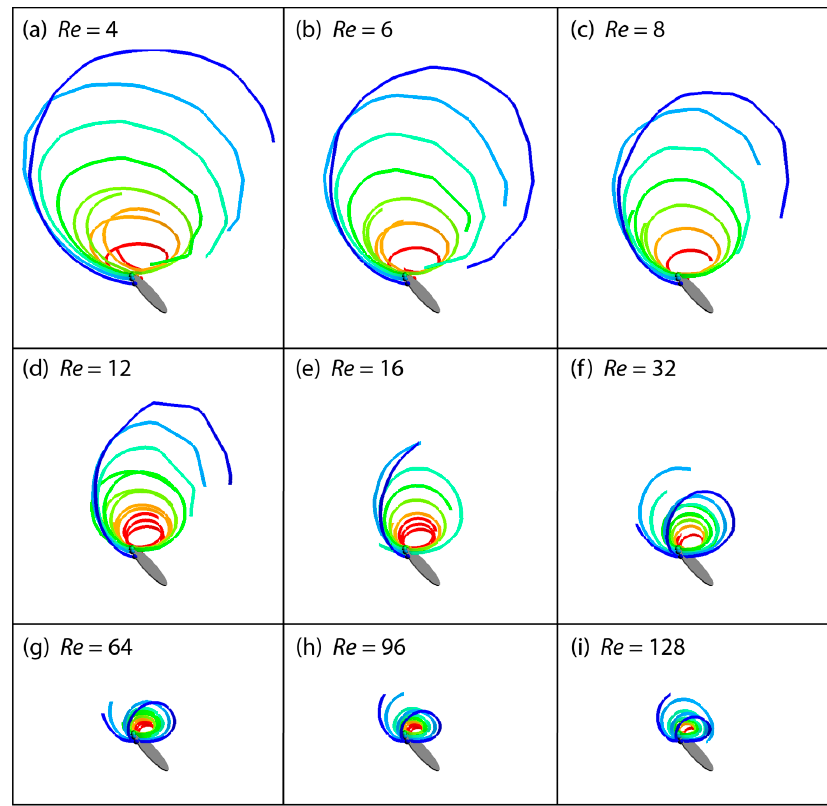
Figure 7. The streamlines around the LEV of the wing at mid-stroke obtained from three-dimensional computational simulations (angle of attack = 45°, Re ranges from 4 to 128). The TEV is not shown. Seven streamlines are evenly spaced along the span of the wing, each originating at the leading edge. Streamlines are color-coded to indicate starting position. The colors correspond to the position along the span. The blue streamline is furthest from the axis of rotation and the red is the closest. Note that the wing is traveling to the